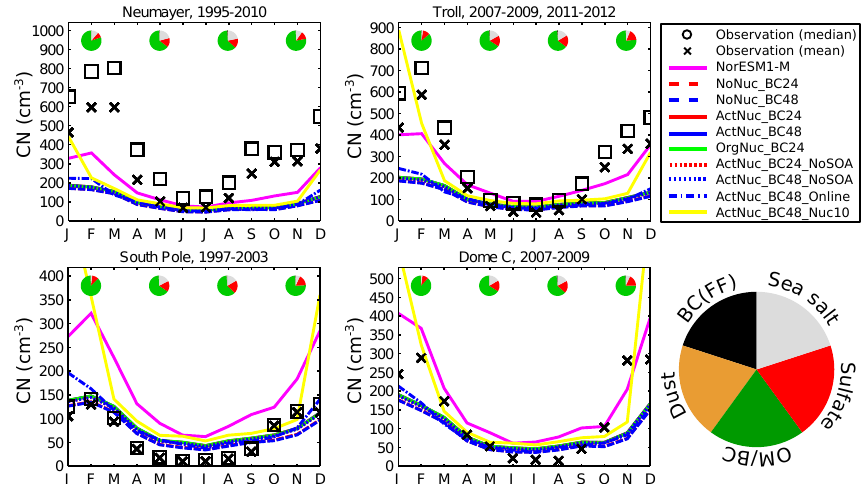
Figure 7. As Fig. 5, but for Antarctic